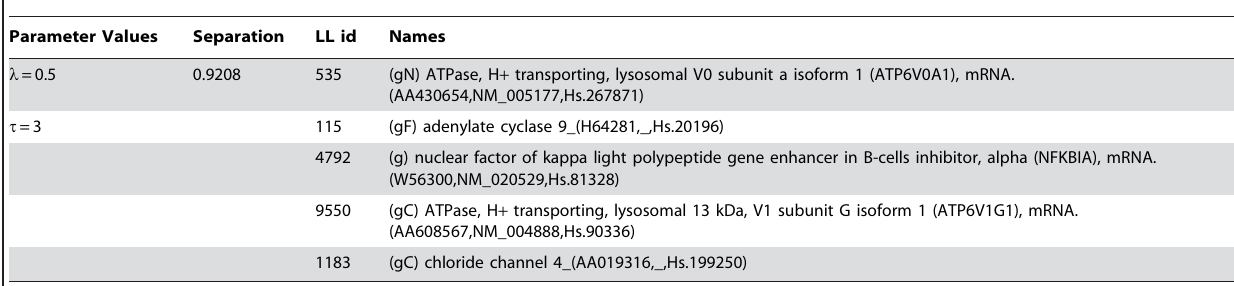
Table 2. Top 5 identified genes by IMGO for various values of separation.